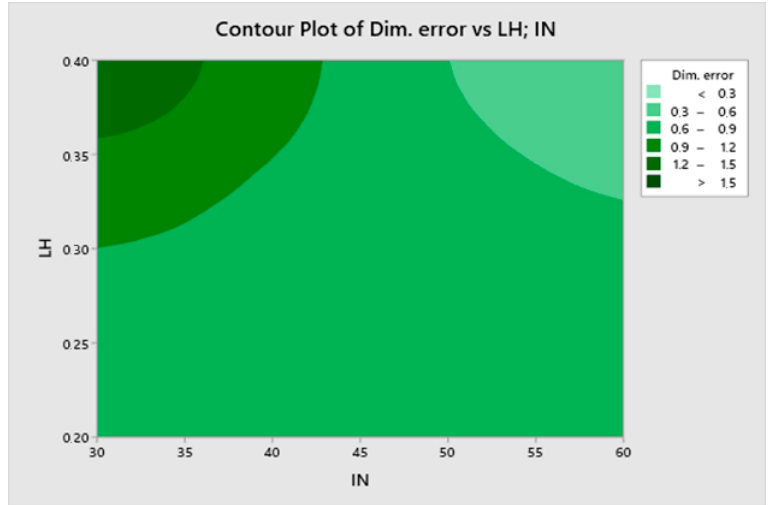
Figure 4. A contour plot of dimensional error (%) vs. infill and layer height.